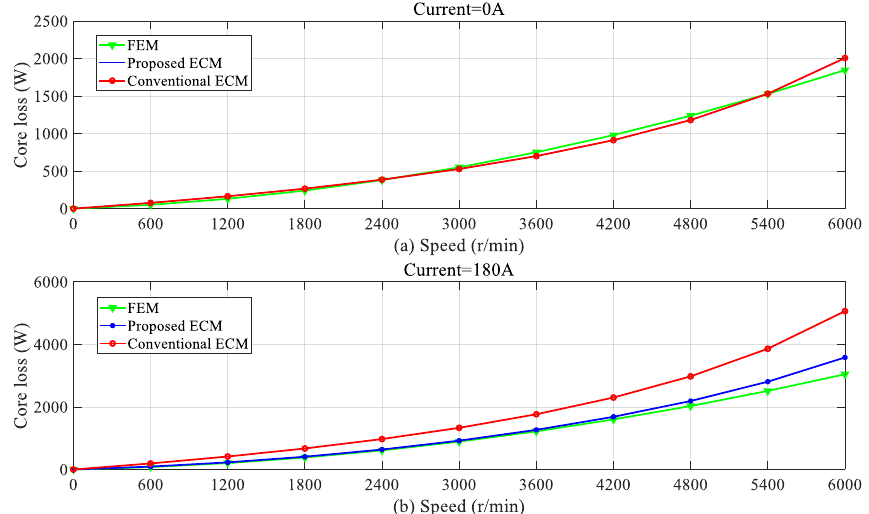
Figure 18. Core loss versus motor speed: ( a ) no-load conditions; ( b ) rated current conditions. To have an overview of all the ECMs with predictable core loss mentioned above, a comparison is made with five indicators, as shown in Table 2. Table 2. Comparison of the ECMs.